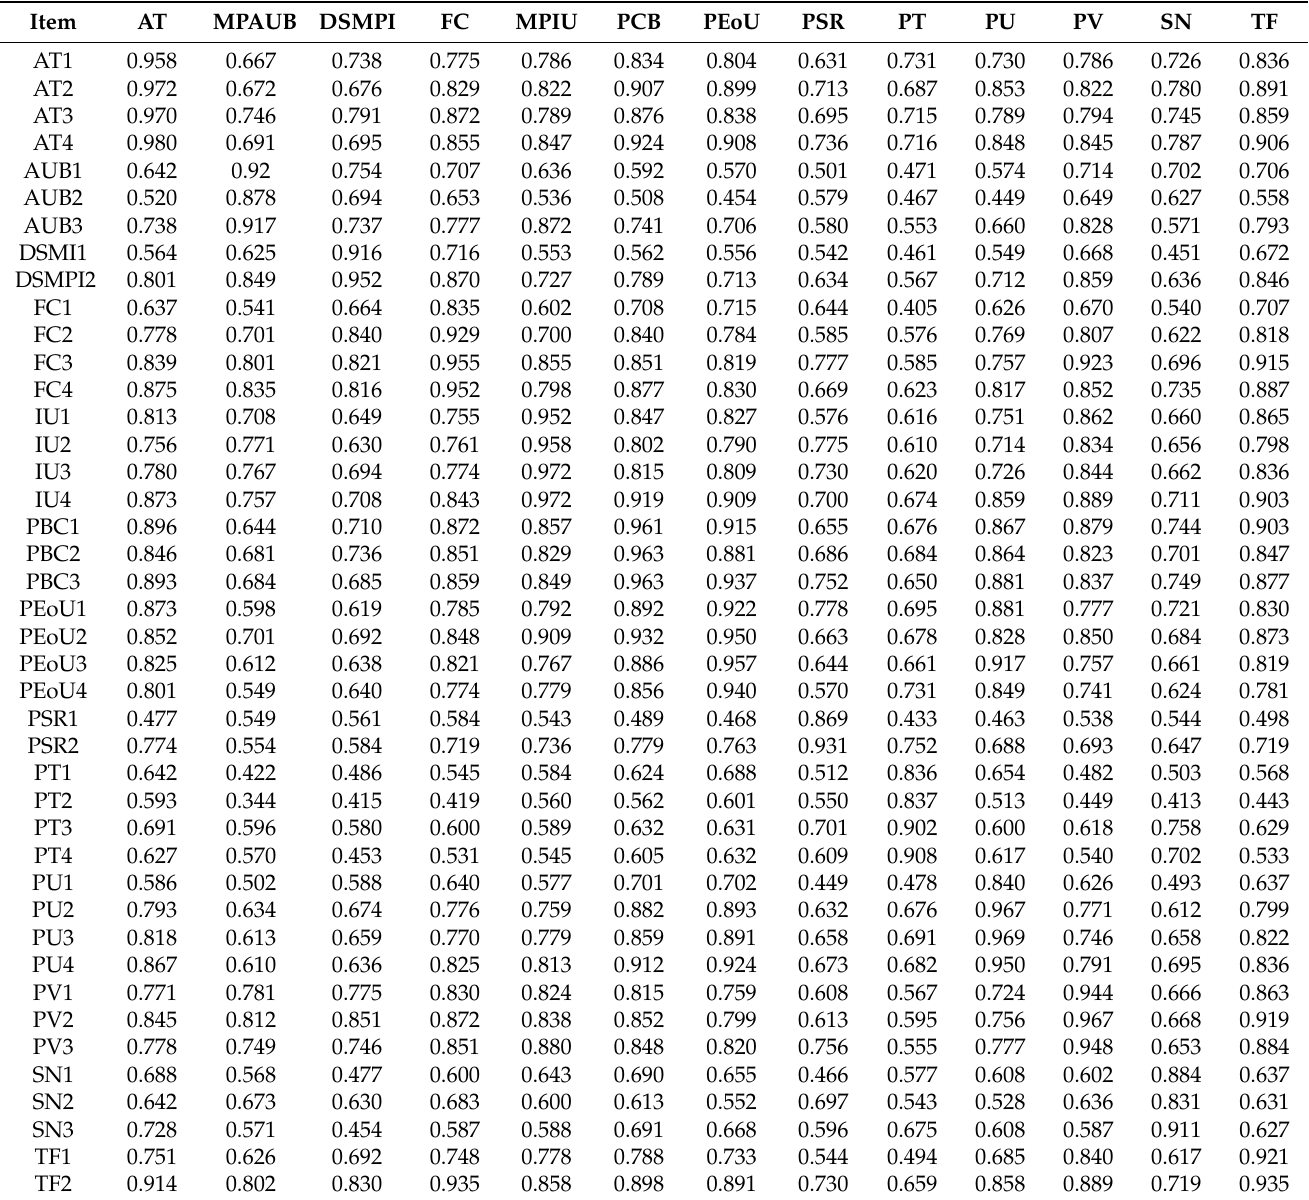
Table 3. Discriminant validity—cross